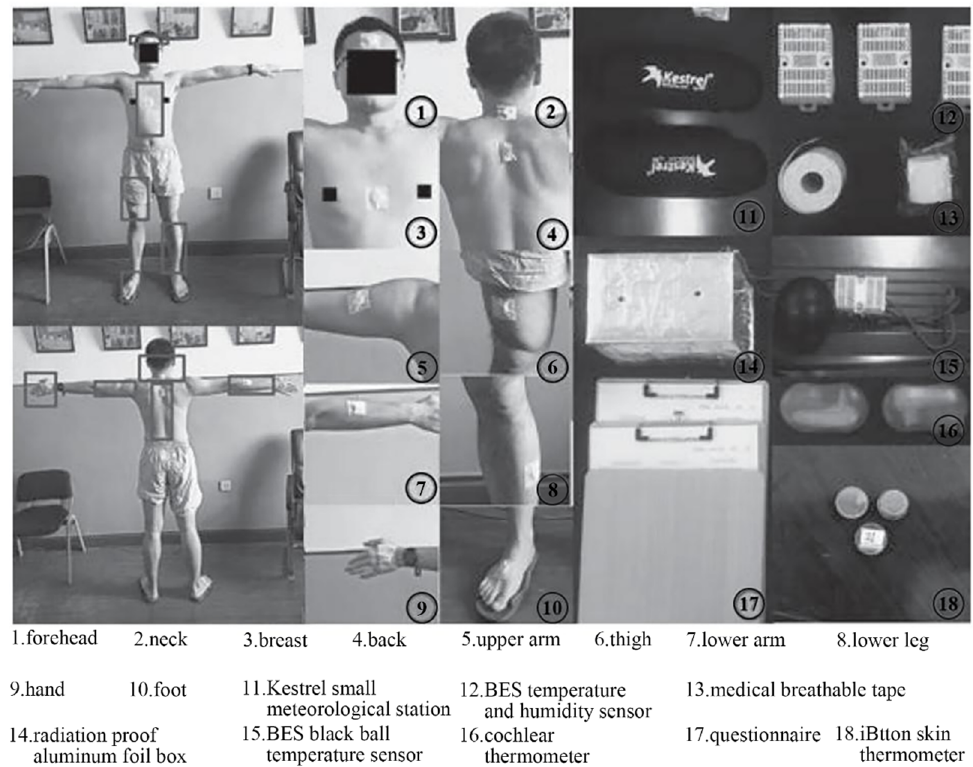
Figure 5. Partial skin temperature test point and experimental instruments.